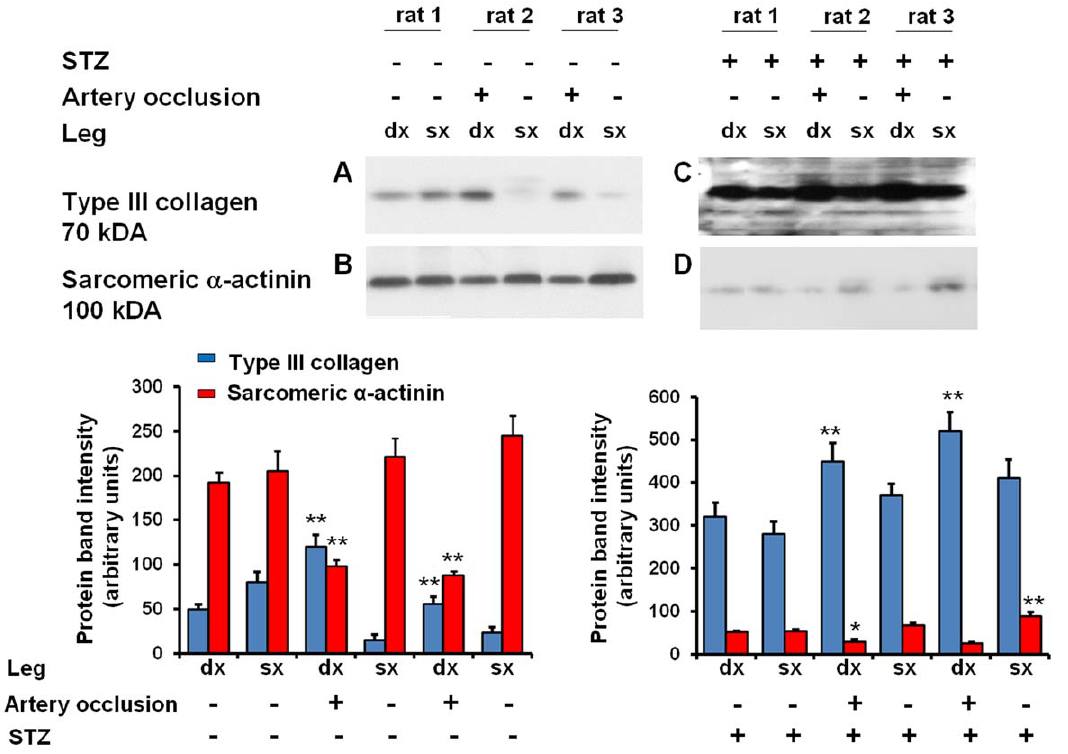
Figure 8. Immunoblotting analysis. Panels A and B: Representative immunoblotting (upper panels) and densitometric quantification (data normalized for GAPDH, lower panels) of sarcomeric a -actinin and type III collagen expression in non-occluded limbs ( panel A ) or occluded limbs ( panel B ) from non-diabetic rats. Panel C and D: Representative immunoblotting of sarcomeric a -actinin and type III collagen expression in non- occluded limbs (panel C) or occluded limbs (panel D) from diabetic rats. The blots show increased expression of type III collagen (upper panels) and decreased expression of sarcomeric a -actinin (lower panels). The same blots reprobed with an anti-GAPDH antibody were used as controls for equal loading (not shown). Values are mean 6 SD of three independent experiments, with n=3 rats for each group. * p , 0.05 and ** p , 0.05 vs normal (non-occluded hind limb). Legend: STZ, streptozotocin-treated rats.